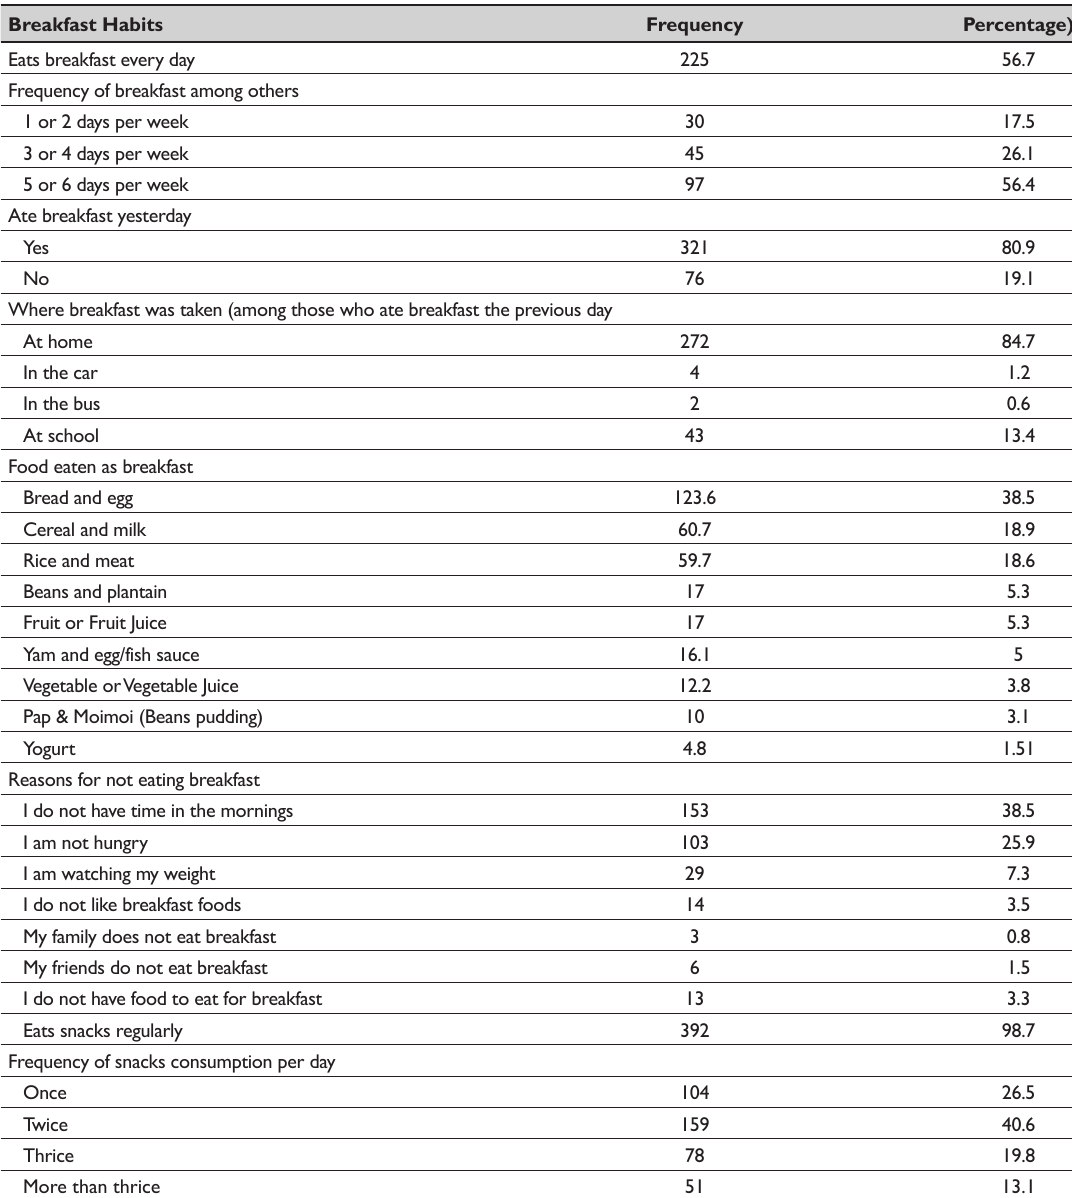
Table 2: Respondent’s breakfast consumption habits Breakfast